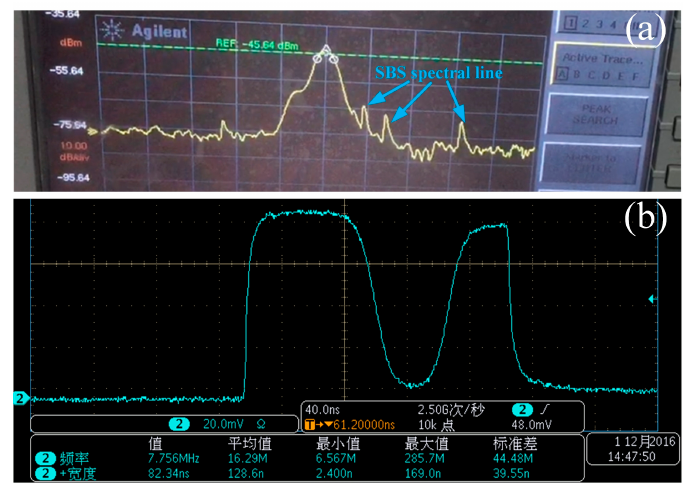
Figure 2. The results are measured at a pulse repetition rate of 100 kHz with a pulse duration of 168 ns. ( a ) Raman frequency shift from the stimulated Brillouin scattering (SBS) effect; ( b ) pulse distortion due to backward SBS generation.